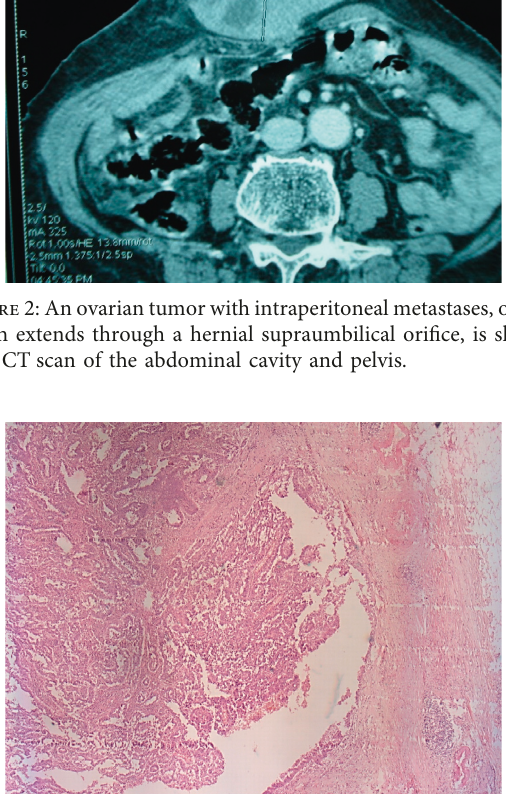
Figure 3: The umbilical nodule’s microscopic features reveal a carcinomatous growth of glands and papillae lined by cuboidal cells with severe nuclear atypia (HEX